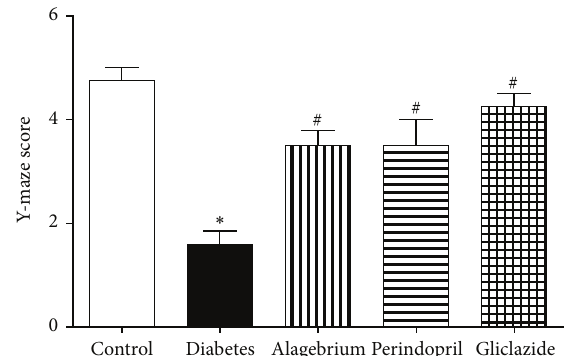
Figure 3: Effects of alagebrium (10mg/kg), perindopril (4 mg/kg), or gliclazide (10mg/kg) on Y-maze score in STZ-induced diabetes in rats. Data are presented as mean ± SEM ( 𝑛 = 6 ). ∗ Significantly different from control group. # Significantly different from diabetic group at 𝑃 < 0.05 using ANOVA followed by Tukey’s post hoc